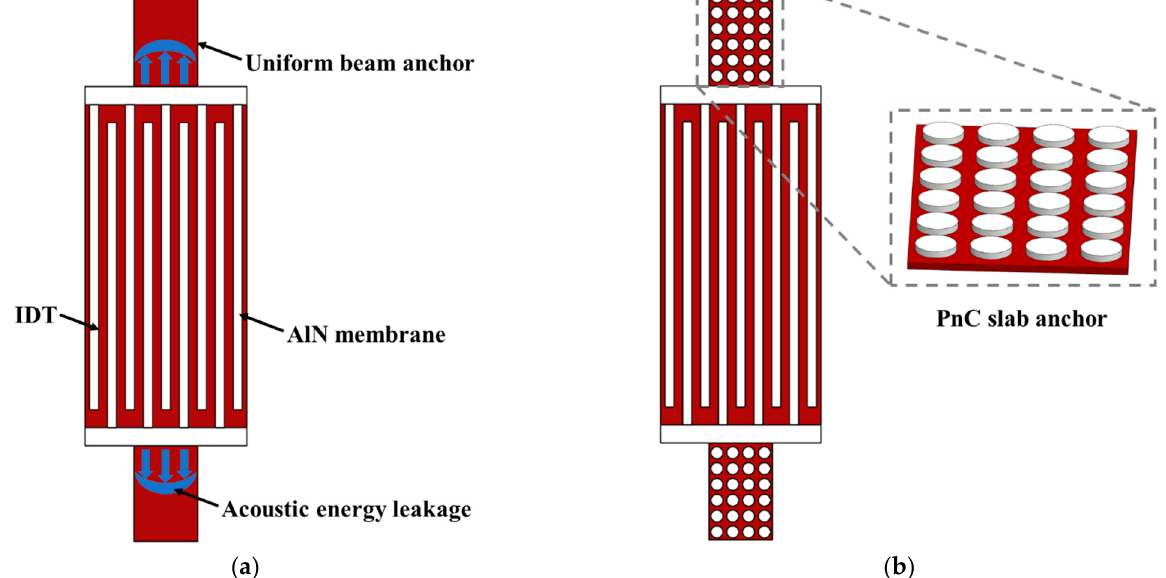
Figure 1. Illustrations of lamb wave resonators (LWRs) with ( a ) uniform beam anchors and ( b ) phononic crystal (PnC) slab anchors.